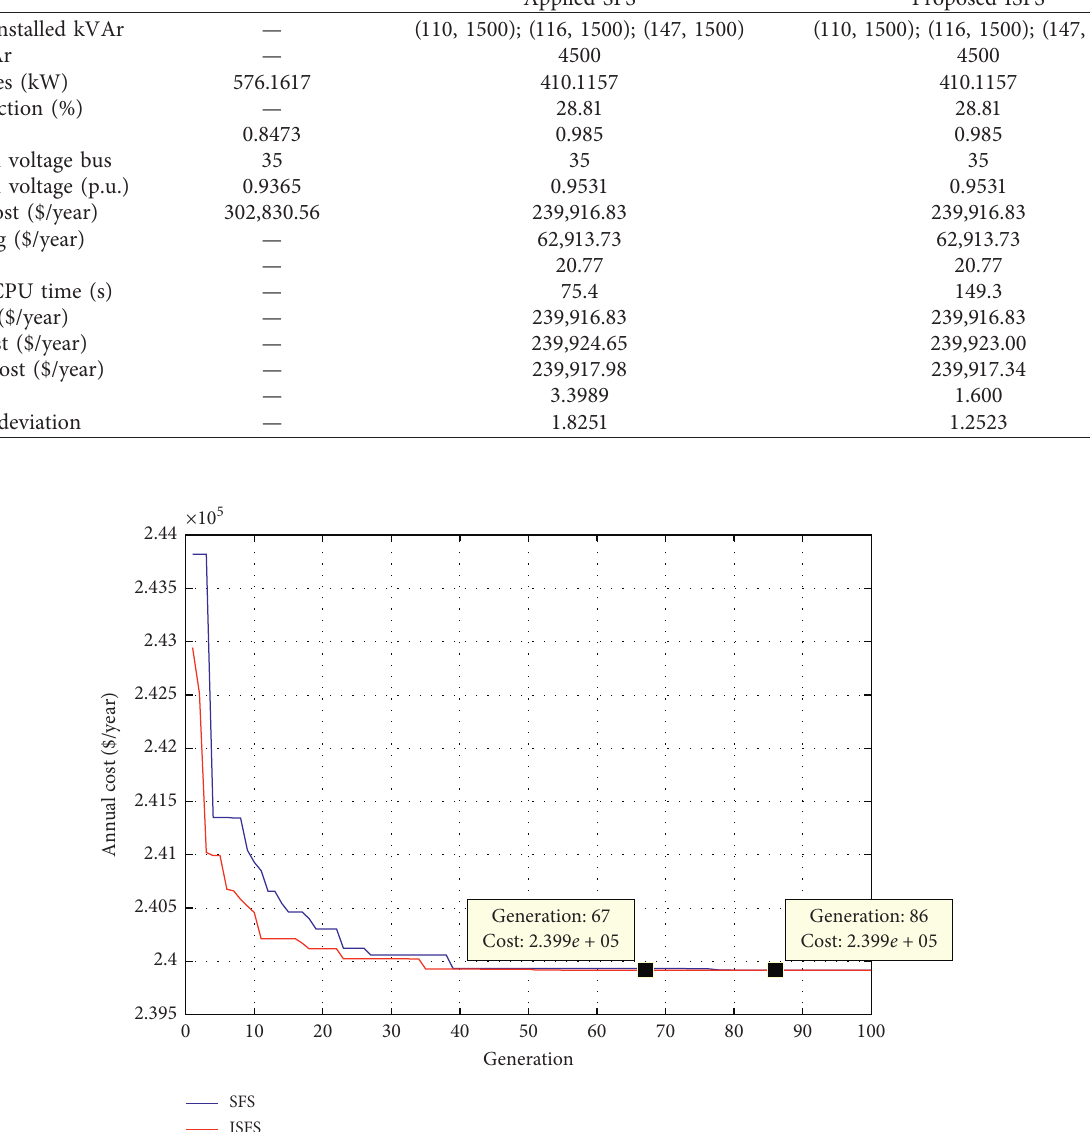
Figure 25: Convergence characteristics of annual cost for 152-bus network with 100% loading in scenario